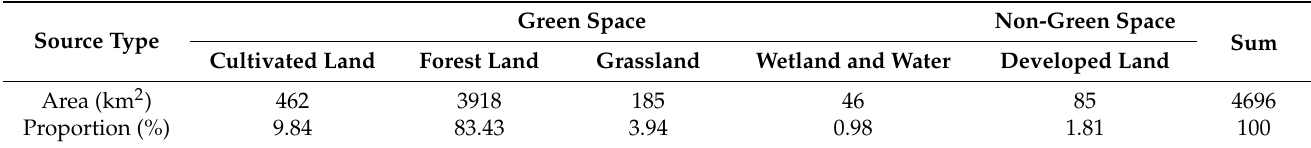
Table 3. Area proportion of the types of green spaces in the ecological sources of